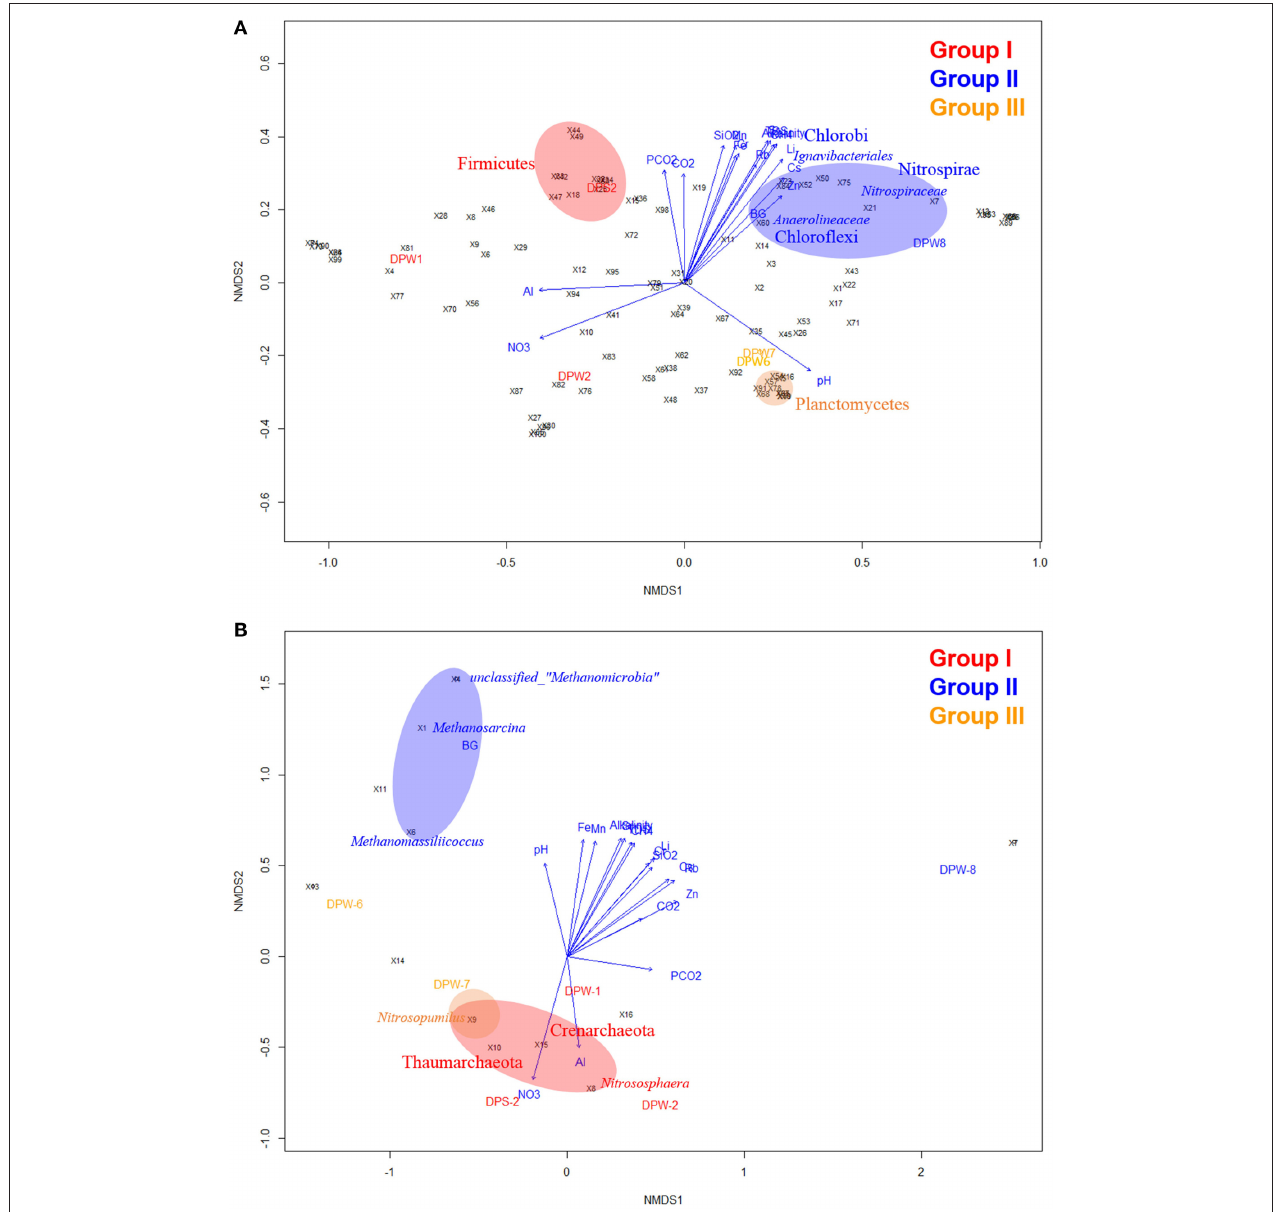
FIGURE 3 | Non-metric multidimensional scaling (NMDS) plot of environmental variables and microbial community compositions in groundwater. NMDS analysis within the vegan package of R software package based on dissimilarities calculated using the Bray–Curtis index of bacterial (A) archaeal (B) communities composition for the relative abundance of each OTU in relation to the environmental variables. The direction and length of the vectors of groundwater factors from Table 1 are computed by Bray–Curtis distances the “envfit()” function in the vegan package. Each sampling location is coded by the color text (green, group I; red, group II; and blue, group III). The number after the symbol “ × ” indicates the specific bacterial and archaeal taxa which are shown in Tables S5, S7, respectively.